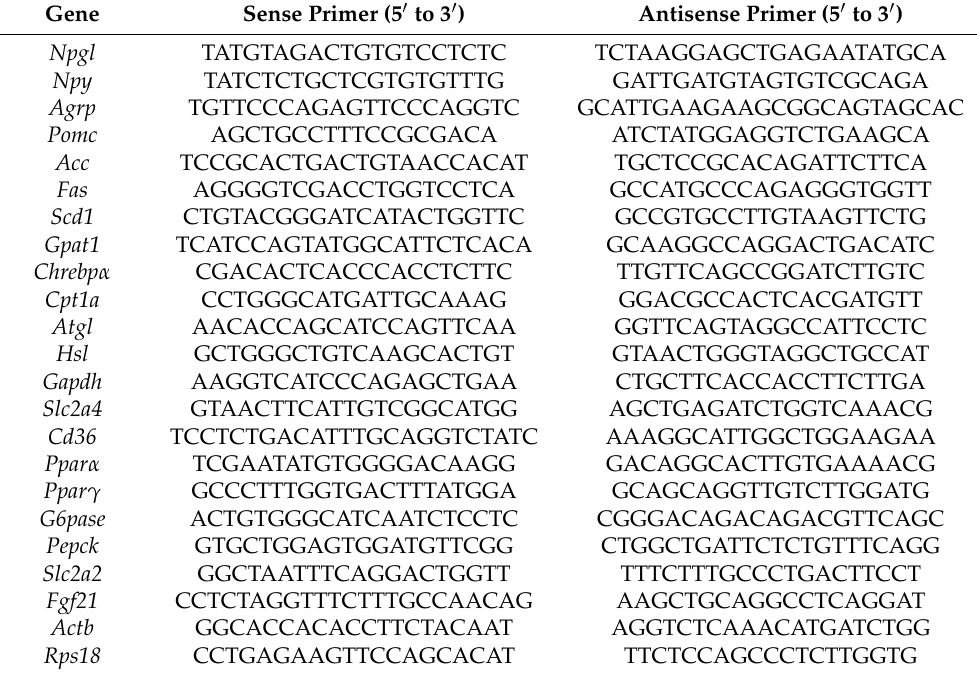
Table 1. Sequences of oligonucleotide primers for quantitative RT-PCR. Gene Sense Primer (5 (cid:48) to 3 (cid:48) ) Antisense Primer (5 (cid:48) to 3 (cid:48)